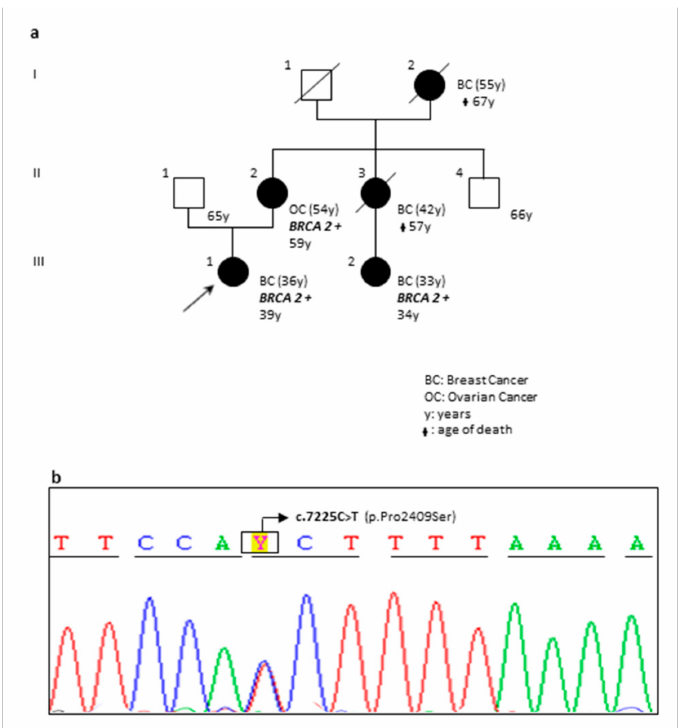
Figure 4. Pedigree and sequencing results of patient carrying the novel BRCA2 c.7225C > T; p.(Pro2490Ser) variant. ( a ) Pedigree of the proband’s family with three generations depicted. Proband is indicated with an arrow. Black circles indicate affected individuals. Cancer type and age at diagnosis are reported and described as: BC, breast cancer; OV, ovarian cancer. The current age and age of death are also reported. Family members carrying the pathogenic variant are marked with BRCA2 + . ( b ) Electropherogram showing the BRCA2 c.7225C > T variant causing the p.(Pro2490Ser) aminoacidic substitution within exon